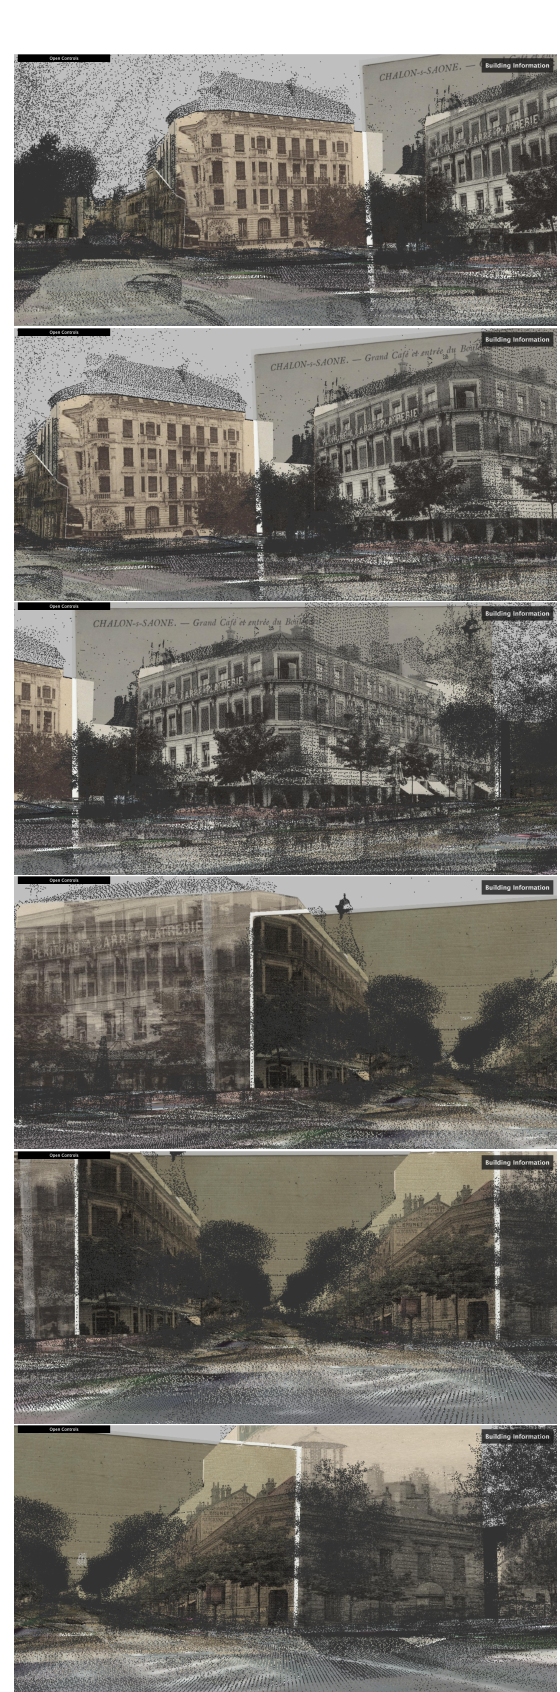
Figure 6. Snapshots of an animation: the user is moving and turning to its right, showcasing how the reprojected photographs are blended together to give some feeling of immersion in a 3D virtual